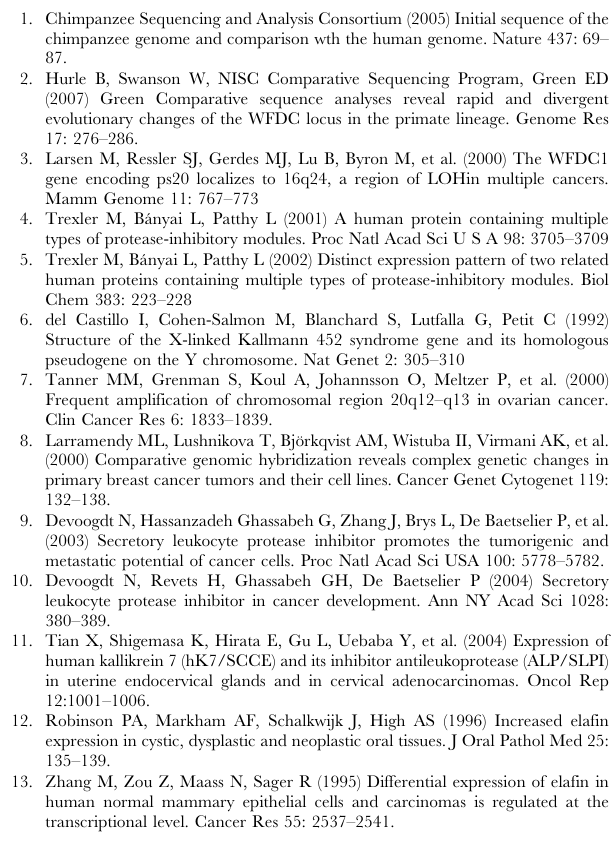
Figure S1 Effect of different reagents and conditions on the oligomerization of HE-4 was measured by DLS. Plot was drawn as a function of concentration of reagents and conditions as a function of X axis with hydrodynamic radii of protein on Y axis. (A) Effect of pH 2–10 empty circle) and different salt: MgCl2, FeCl2, CuCl2, CaCl2, ZnCl2 and ZnCl2 + EDTA (filled circle). And (B) Effect of DTT (filled circle) and CHAPS (empty circle) in varying concentration (1%–5%). (C) Effect of SDS (filled circle) and Tween-20(empty circle) in varying concentration (2.5%–10% and 0.005%–0.05%) respectively. (D) Effect of Triton X- 100(empty circle) and b -mercaptoethanol (filled circle) in varying concentration (0.1%–1.0% and the 5%–10%)